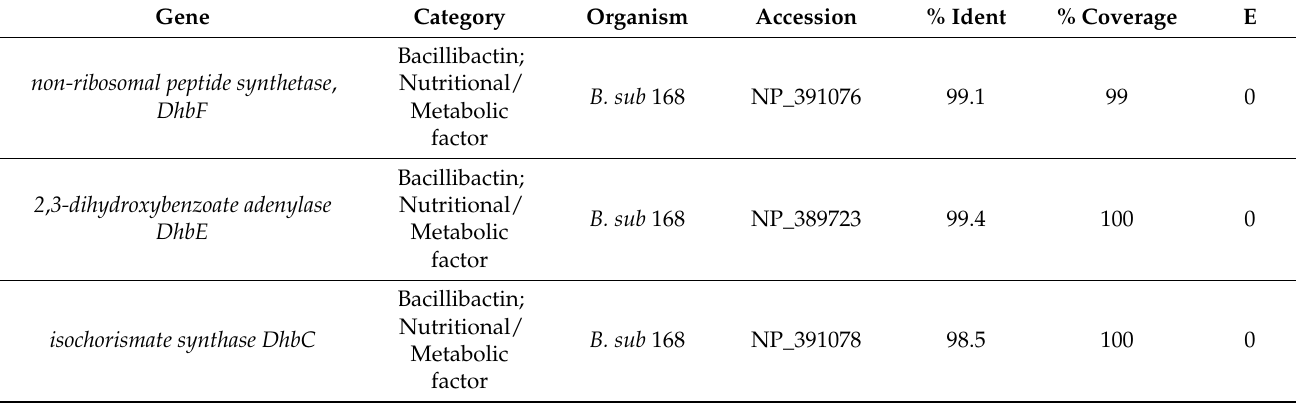
Table 4. Summary of BS50 genome screening for virulence factors using